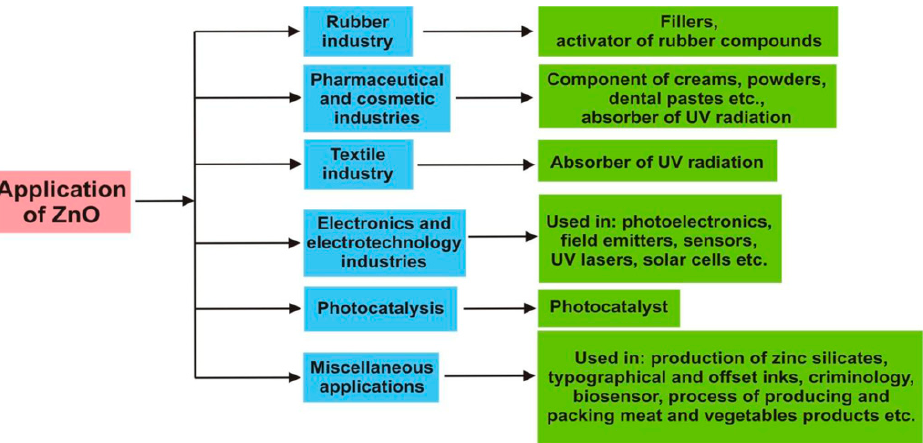
Figure 2. Schematic representation showing versatile applications of ZnO nanoparticles in chemical, electronic, textile, pharmaceutical and cosmetic industries. Reproduced from [35] the terms of the Creative Commons Attribution License (CC BY).